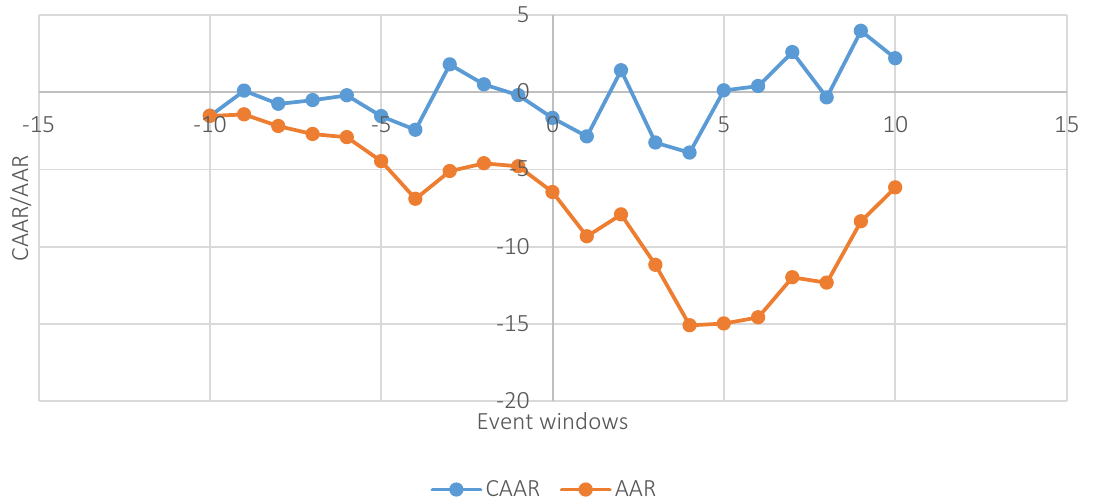
Figure 1. Day-wise AAR and CAAR for the NSE-listed firms to show the impact of the COVID-19 outbreak Table 3. CAAR for the textile, media, financial services, healthcare services, and drug & pharma sectors to show the impact of the COVID-19 outbreak in different event windows Event window